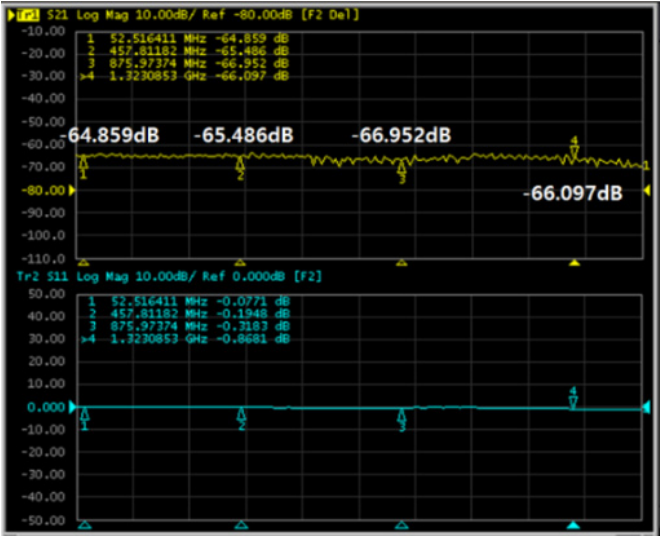
Figure 12. Electromagnetic shielding performance of the metal coating carbon fiber 100 μm.